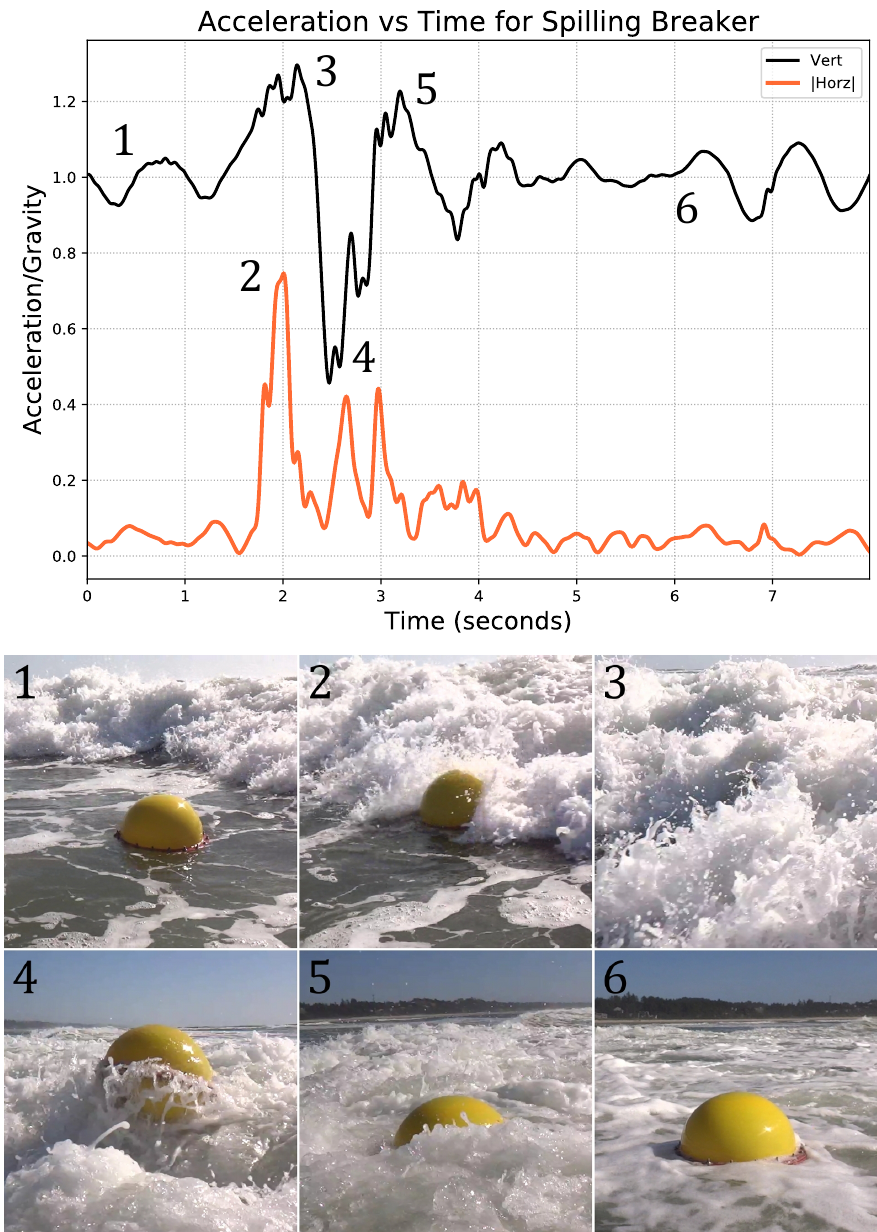
Figure 7. A sequence of screen captures from the video of a spilling wave impact is shown below a plot of the induced buoy accelerations. The buoy is shown: (1) free floating before impact, (2) during the initial impact of the spilling breaker, (3) as it is over-topped and submerged by the spilling wave, (4) rising vertically out of the spilling wash, (5) falling back into the stabilizing rear face of the wave, and (6) regaining stability. Wave recorded on 10 April 2014 at 16:21:06